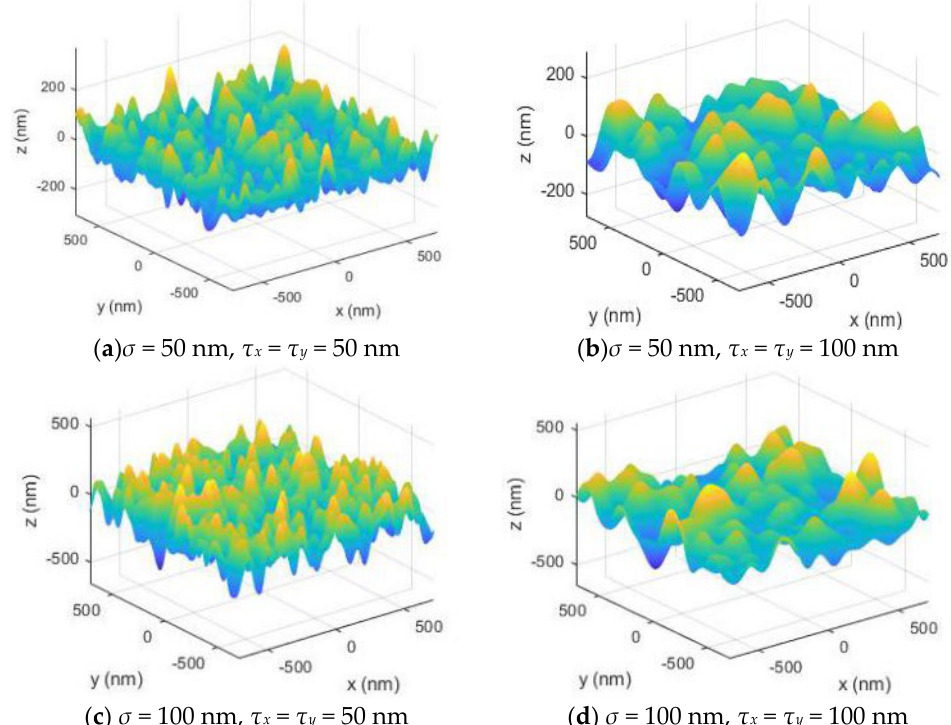
Figure 6. Gaussian random rough surface with different σ and τ.